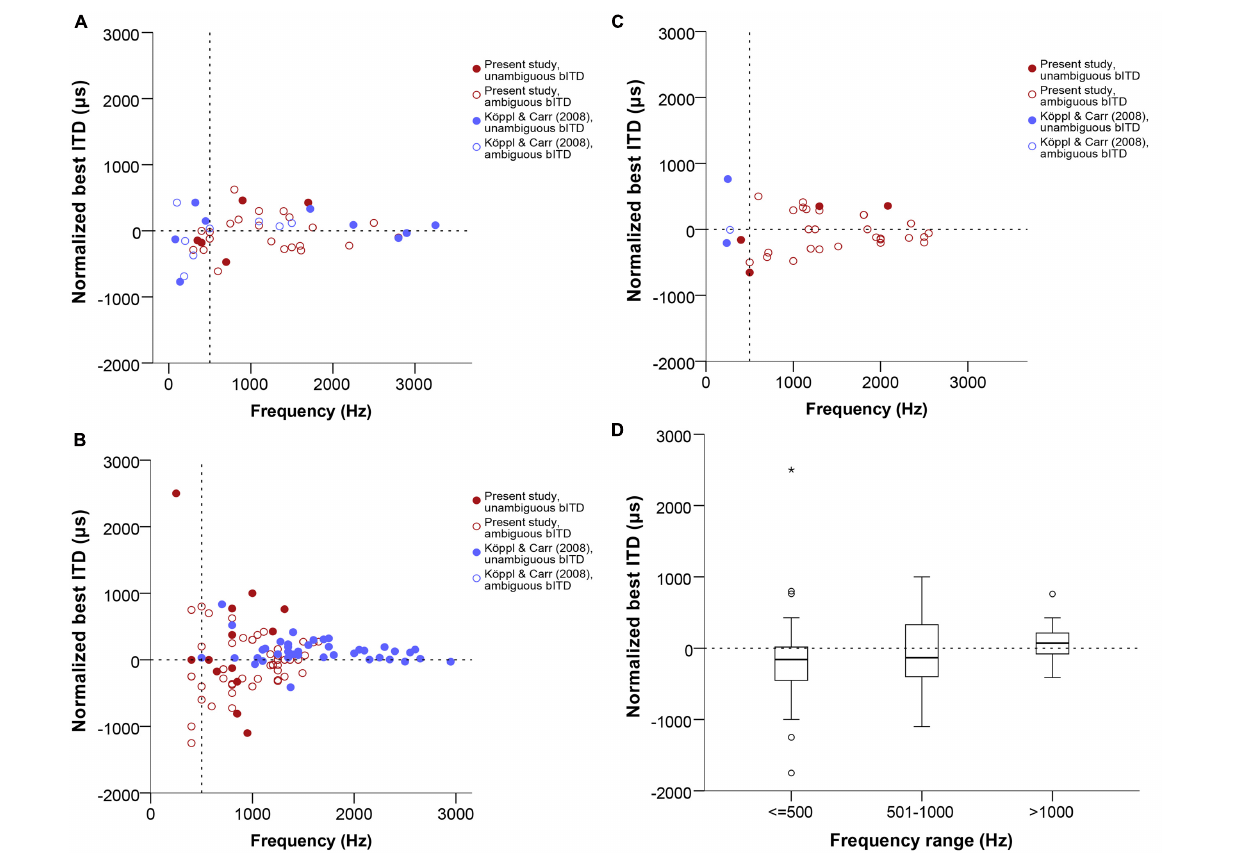
and recording types in µ s at different frequency ranges, expressed in Hz. Solid bars represent the median, boxes represent the interquartile range. Whiskers represent the maximum and minimum of the distribution, circles and stars mark outliers. In all panels negative values represent ipsilateral-leading sounds and positive values represent contralateral-leading sounds. The horizontal dashed line marks the acoustic midline at 0 µ s ITD and the vertical dashed line marks the 500 Hz